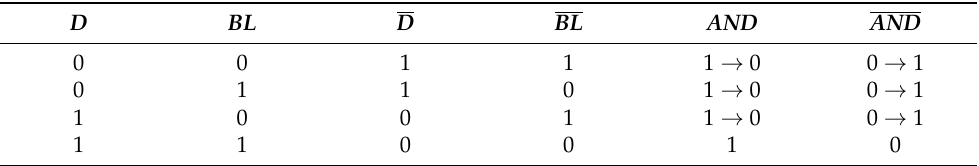
Table 1. The truth table of the dynamic AND cell of Figure 8b. One can notice that, using the current-saving scheme, the AND output is charged to ‘1’ when AND is discharged to ‘0’, while it remains at the ground voltage when AND =